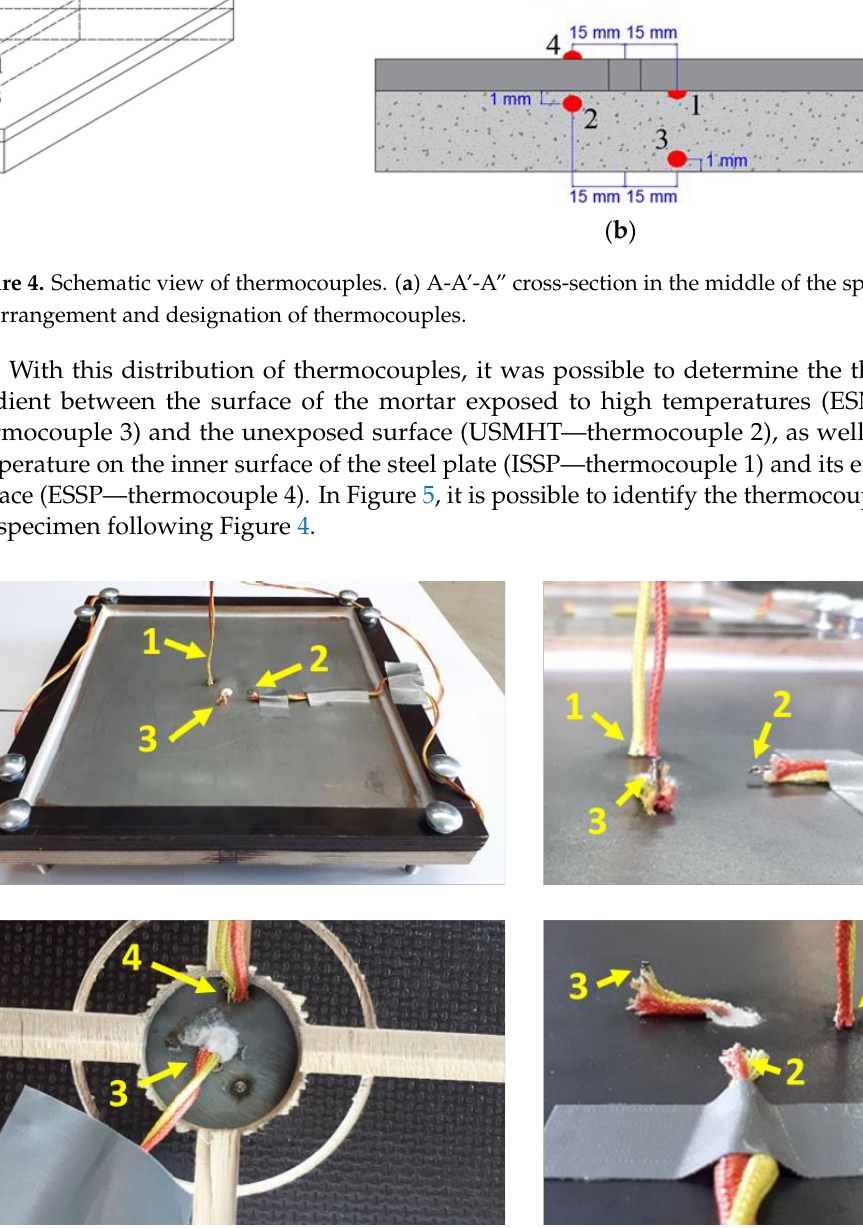
7 of 22 Figure 2. Manufacture of specimens: ( a ) Hobart N50 mixer; ( b ) fresh mortar in the mixer container; ( c ) steel plate with thermocouples applied; ( d ) specimen in the process of curing during the first 48 h.